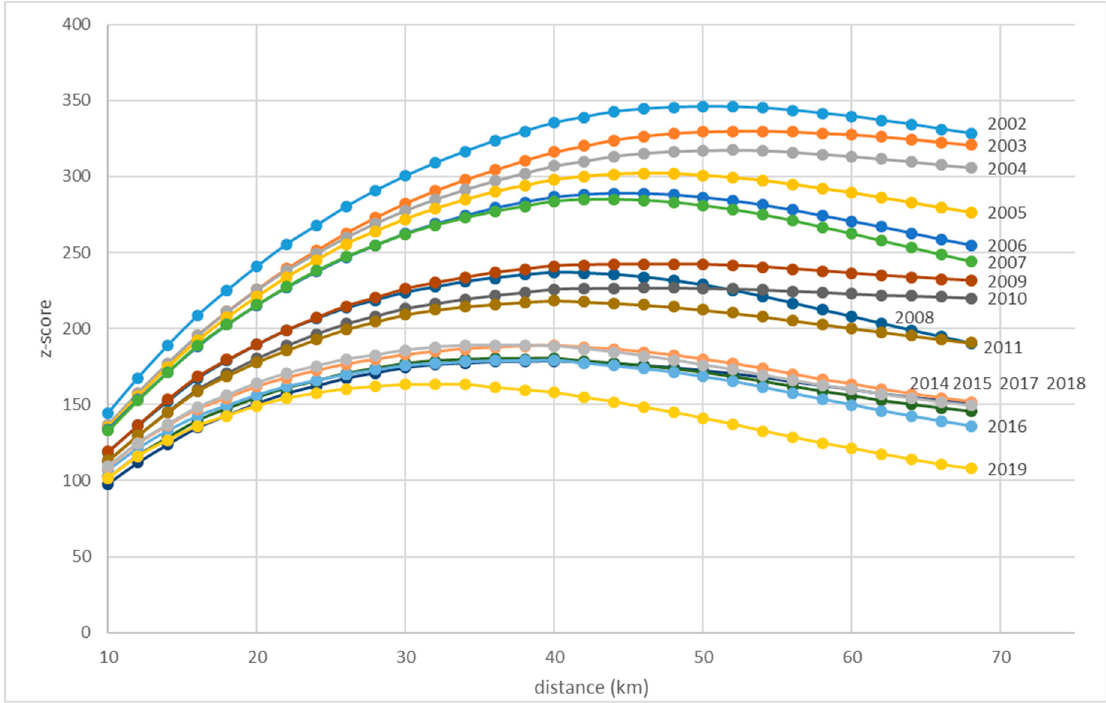
Figure 6. The z-scores significance levels for spatial autocorrelation measured by Moran’s I with 10–68 km distance-based spatial weights for unemployment between 2002 and 2019 in Czechia (municipal level). Source: Ministry of Labor and Social Affairs, Labor Office of the Czech Republic; own calculation.